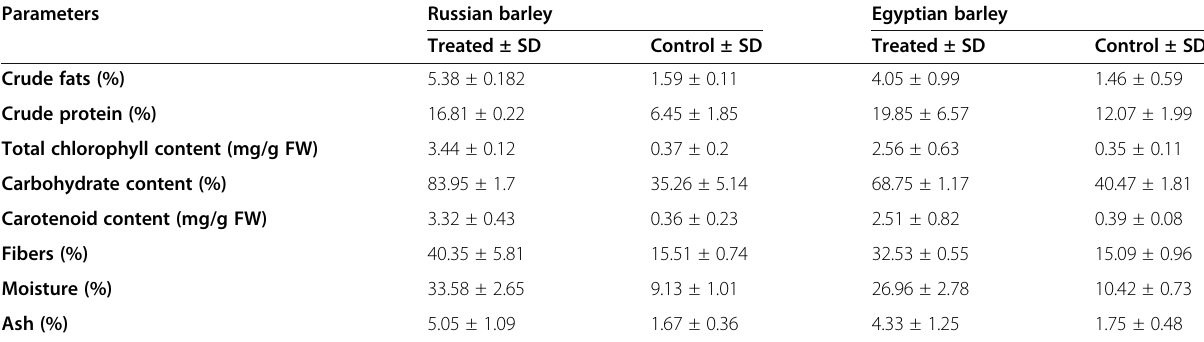
Table 2 Detection of the effect of the endophytic T. harzianum on biochemical metabolites of the sprouting barley plant using the hydroponic system